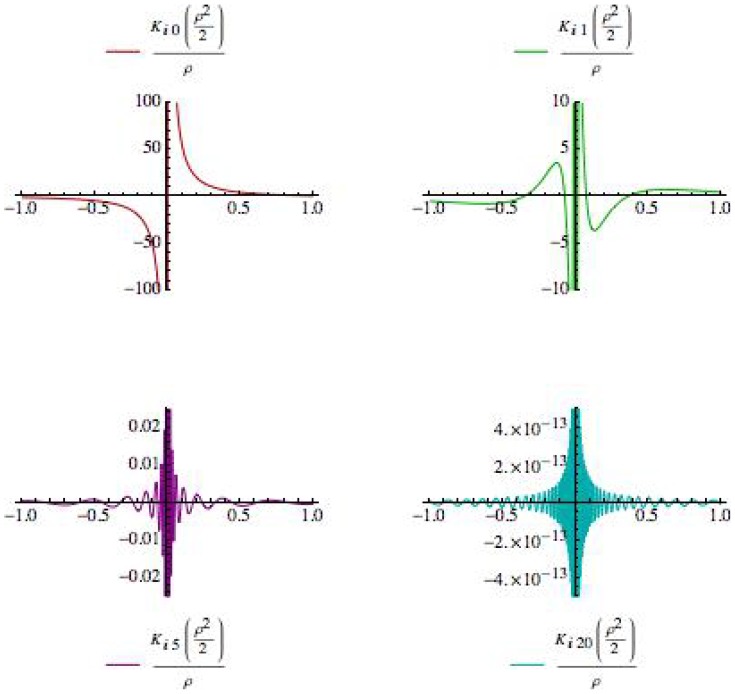
Plots of  for , and .